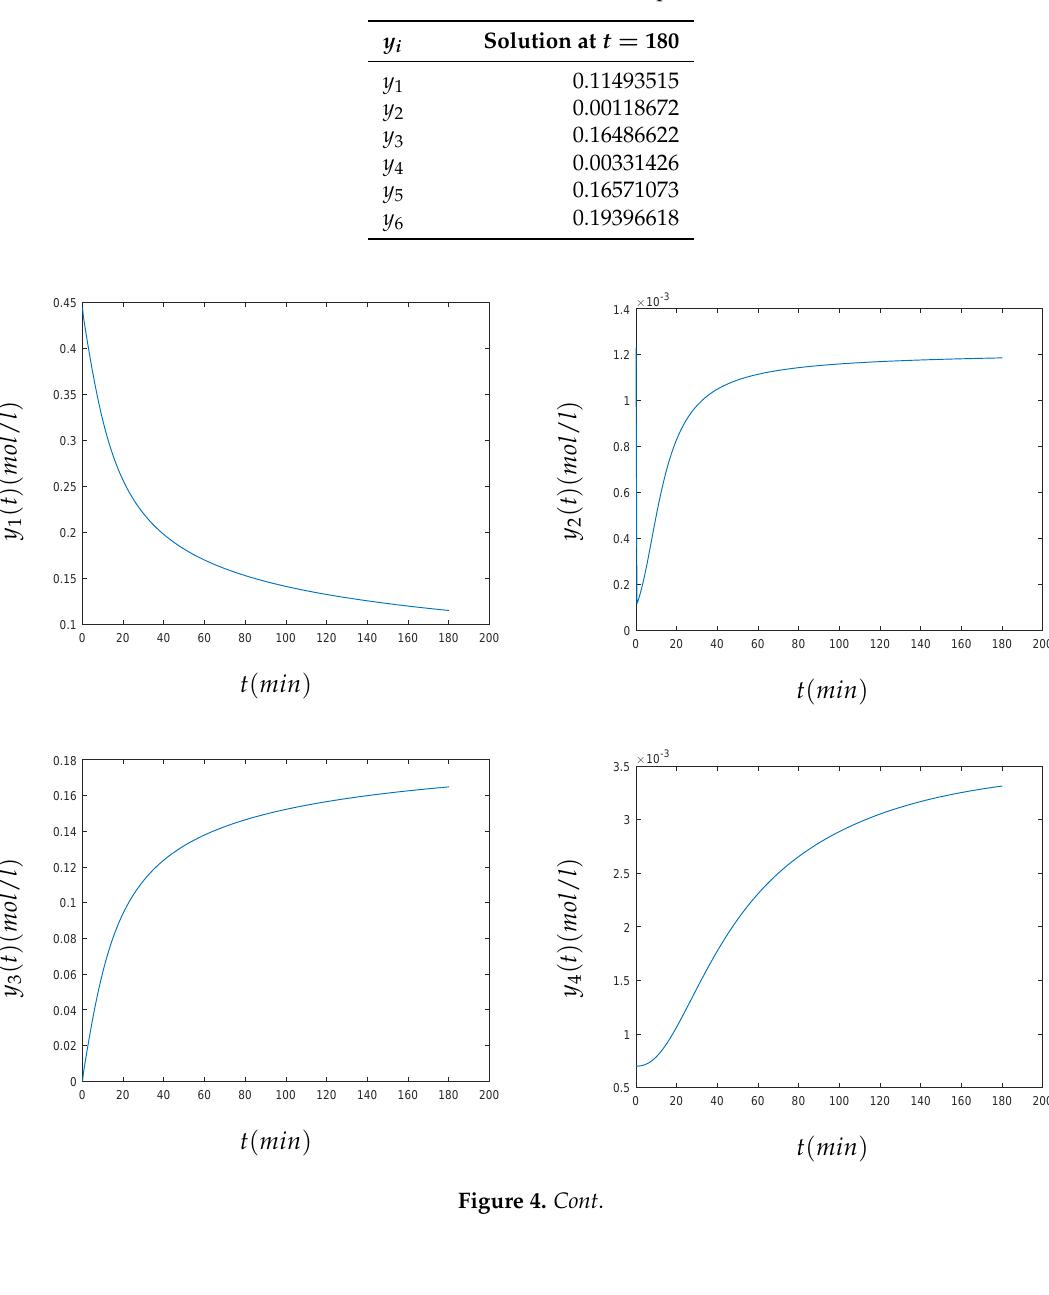
Table 2. Results of the chemical Akzo Nobel problem at t = 180.